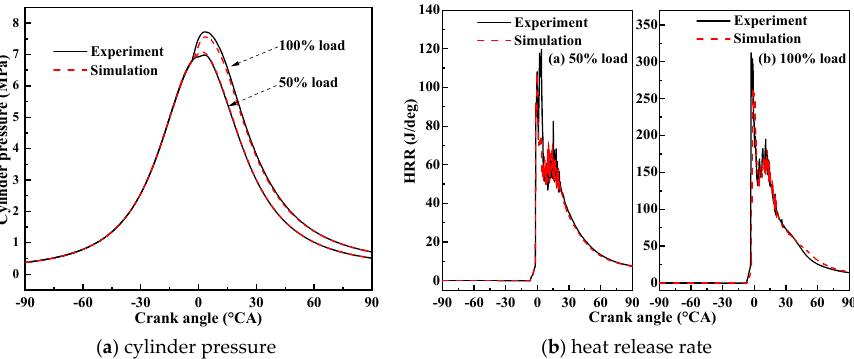
Figure 4. Engine validation results for cylinder pressure and heat release rate.